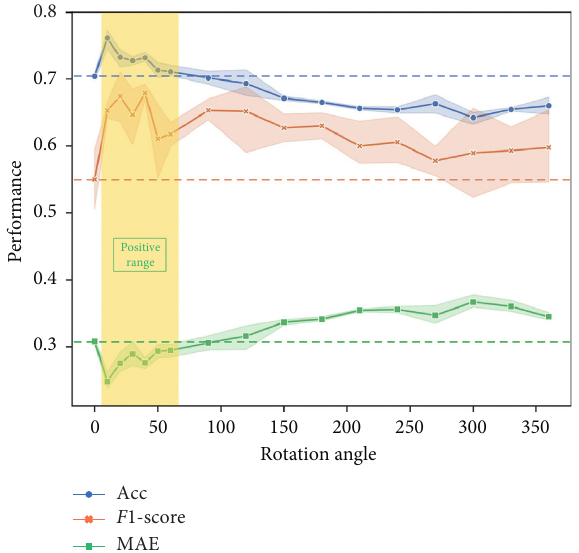
Figure 9: SOCNN’s performance change as the range of rotation angle varies.